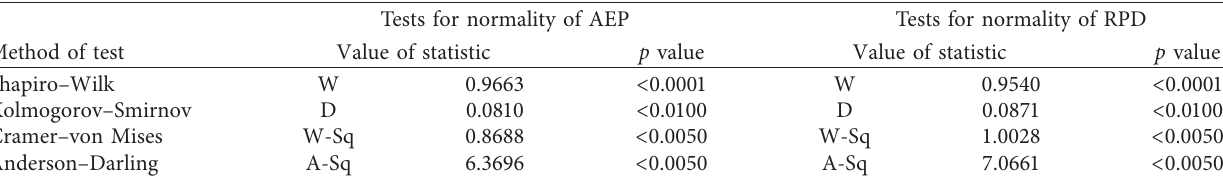
Table 6: Normality tests of AEP and